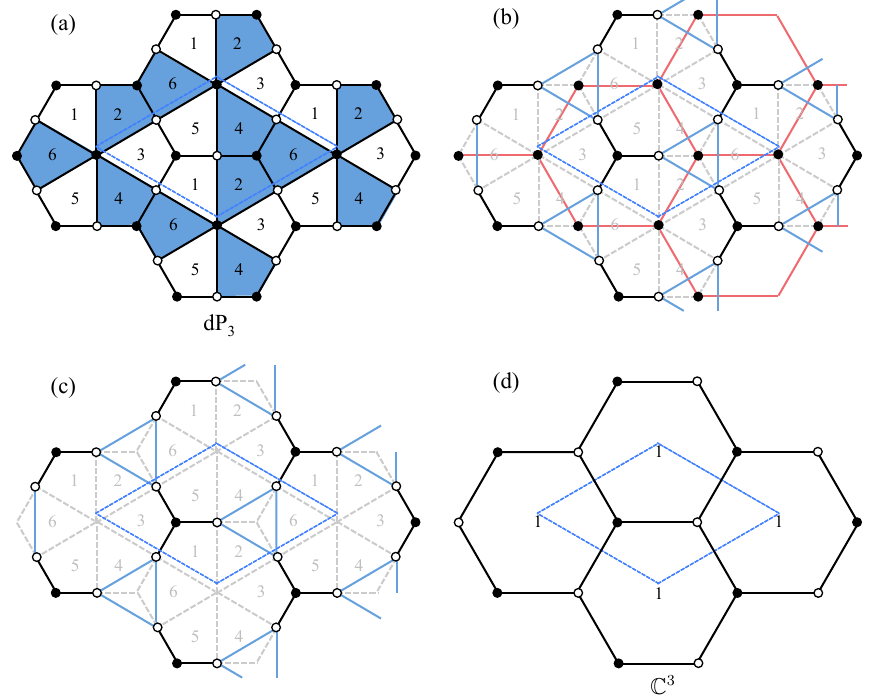
Figure 46. Instanton backreaction from phase 1 of dP 3 to C 3